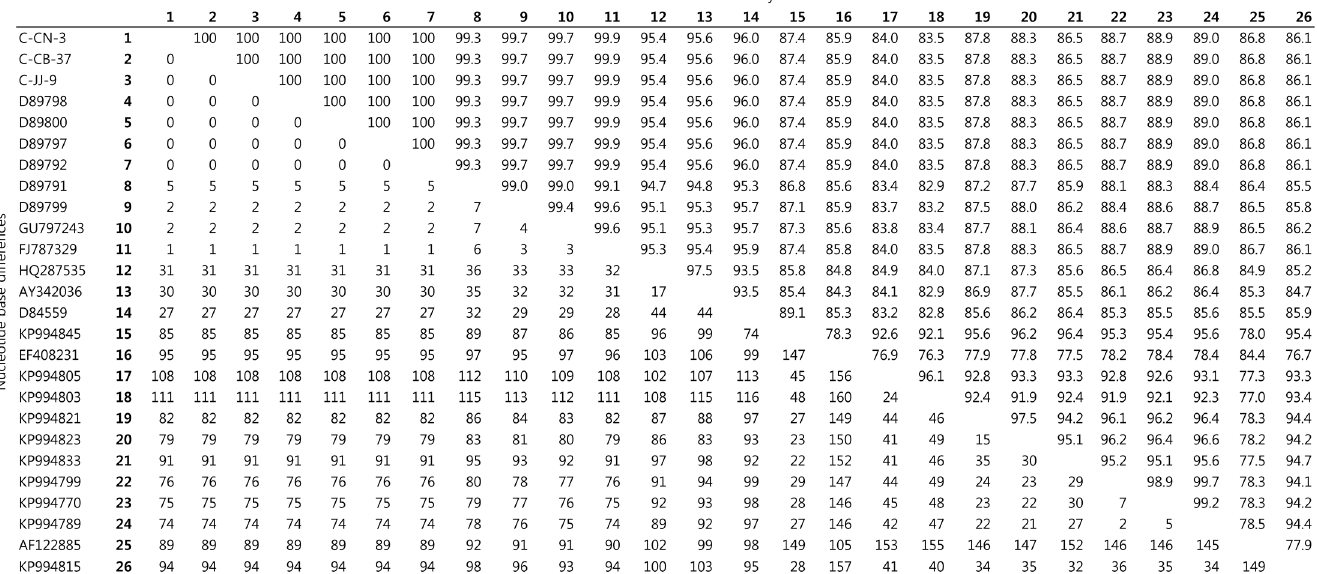
Fig 2. Comparison of the genus Coxiella 16S rRNA nucleotide sequences. Percent identitiesbetweensequencesof Coxiellaburnetii 16S rRNA gene fragment are shown in the upper matrix. The lower matrix shows the numberof nucleotidebase differences.